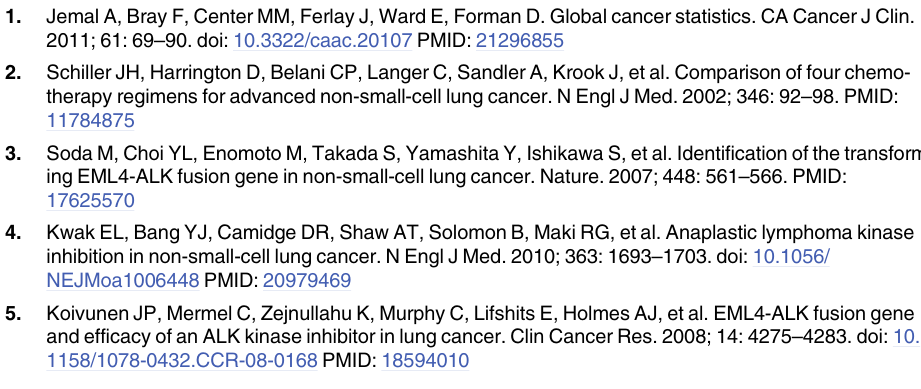
S1 Table. List of ROS1-fusion cases detected by